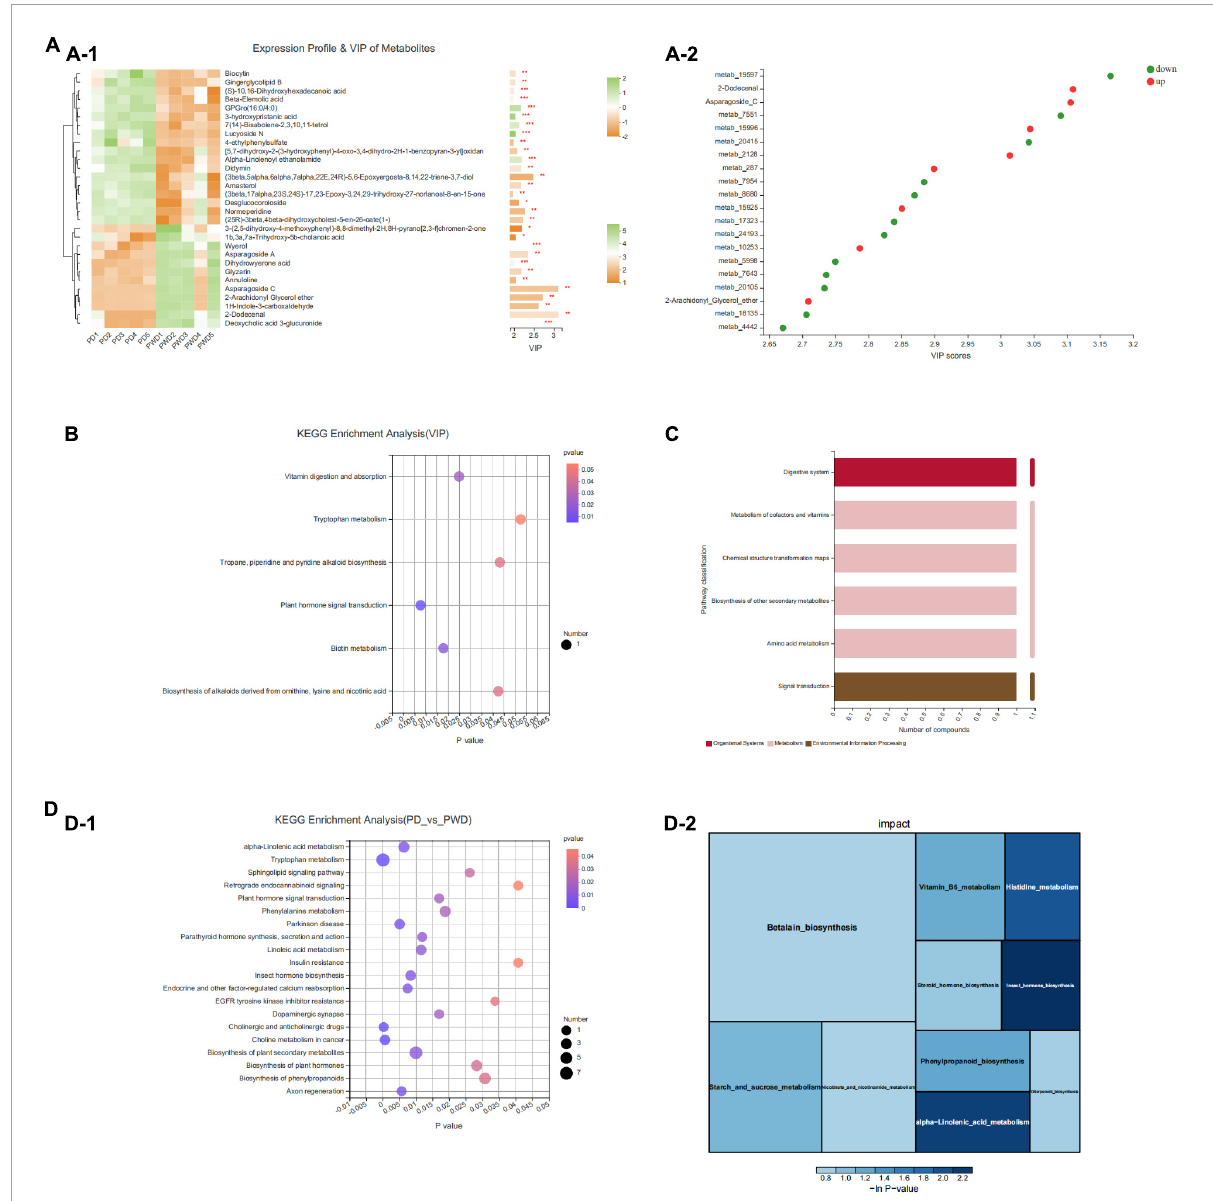
FIGURE6 The result of Fecal Metabolomics. (A) A heatmap of differentially expressed metabolites between the PD and PWP groups showing the top 30 significantly differentially expressed metabolites. (B) Bubble map showing the results of KEGG pathway enrichment analysis. (C) Secondary metabolic classification of KEGG functional pathway. (D) KEGG enrichment analysis of the PD and PWP